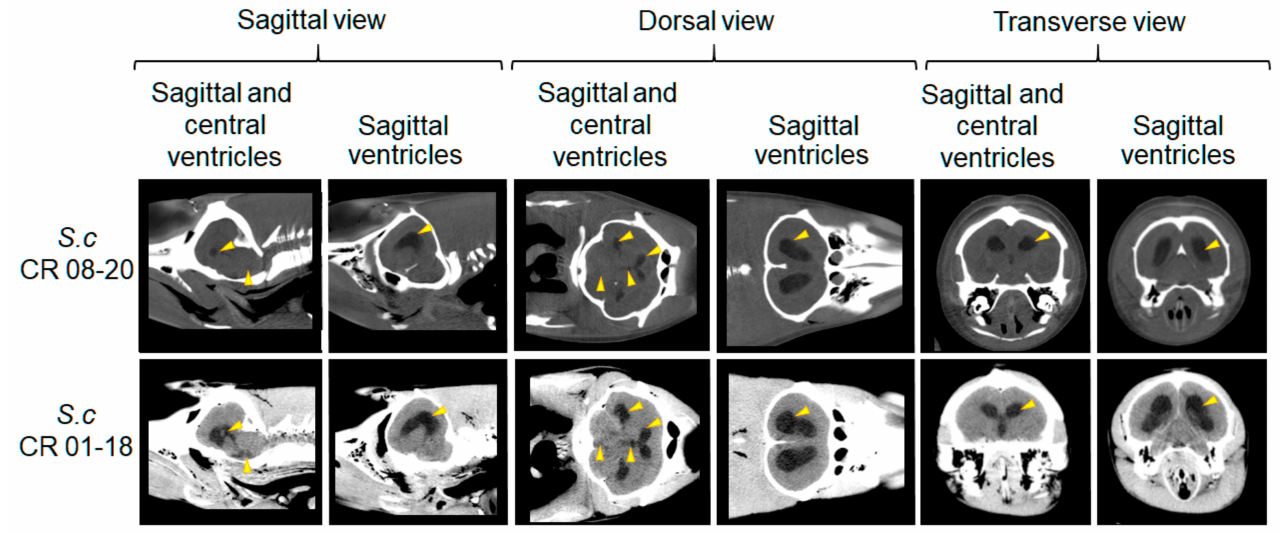
Figure 3. Reconstruction by PMCT of sagittal, dorsal, and transversal virtual brain sections of adult dolphins with neurobrucellosis showing severe ventriculomegaly in the two lateral ventricles and the third and fourth ventricles (yellow point arrows). The planes of the virtual computed tomography sections are as presented in Figure 1. S.c , S. coeruleoalba